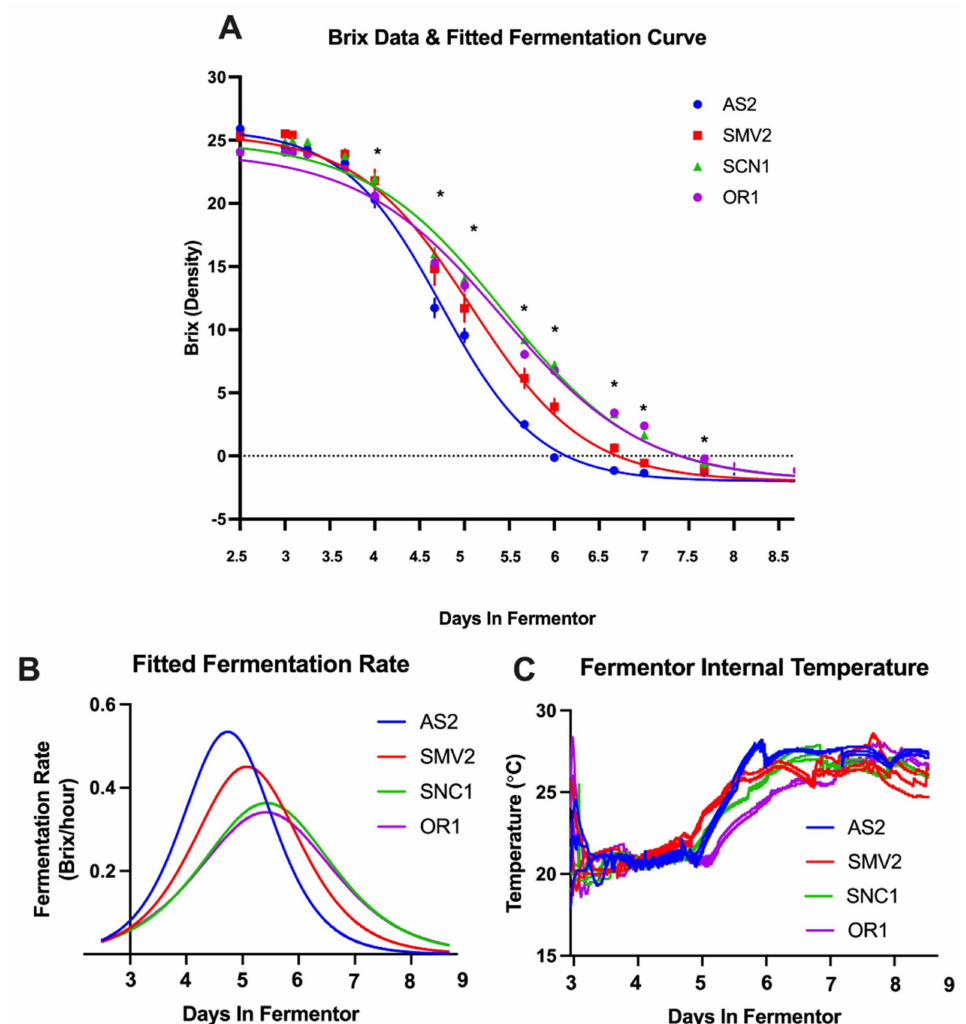
Figure 2. ( A ) The sigmoidal fitted curve reflects the decrease in density (Brix) proportional to the sugars consumed by the yeast; symbols denote manual sample points. A Brix value of 0 or below signals the end of alcoholic (primary) fermentation. The asterisk ( * ) between day 4 and 7.5 indicate where fermentations are significantly different from each other (as determined by Fisher’s least significant difference test, shown in Table S1, Supplementary Materials). ( B ) The fitted rate of fermentation plot shows the two faster fermentations (AS2/SMV2) display a higher initial rate of fermentation (i.e., rate of sugar consumption, Brix/h) than the two slower fermentations (SNC1/OR1). ( C ) The fermentor temperature of each replicate from inoculation through the end of fermentation (additional temperature data are reported in Supplementary Materials, Figure